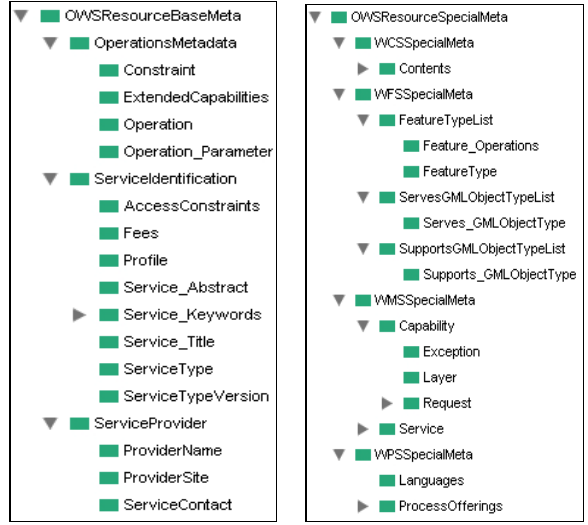
Figure 2. The hierarchical semantic properties representations of OWS (include WCS, WFS, WMS, and WPS)